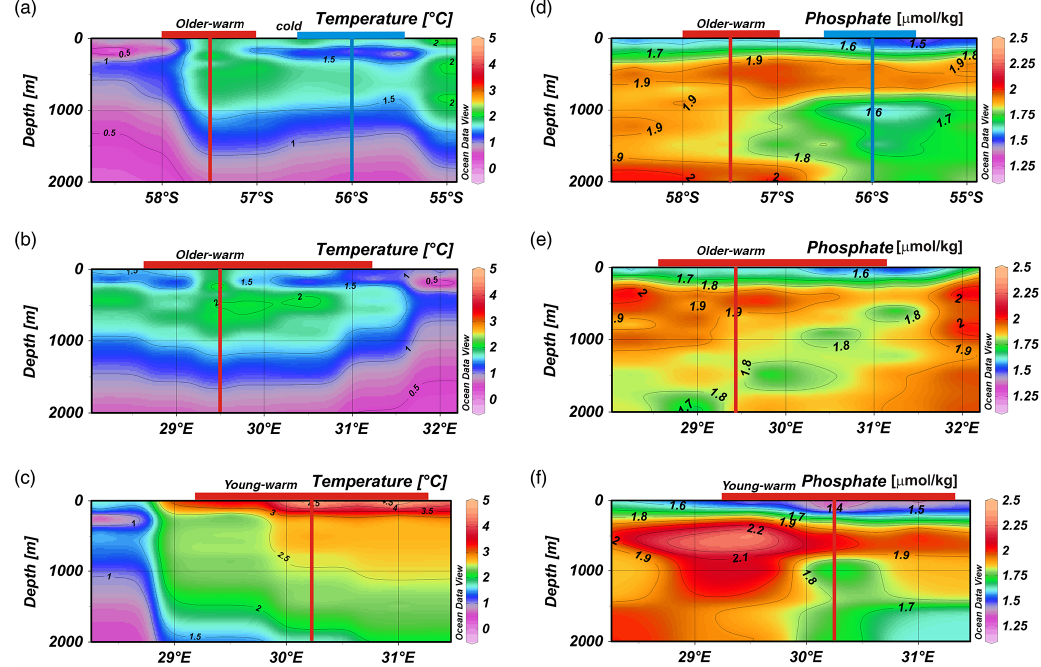
Figure 3. Temperature and dissolved phosphate profile data to a depth of 3000m, for Transect E1 ( a and d ), Transect E2 ( b and e ) and Transect E3 ( c and f ). Vertical red lines (at 57.5 ◦ S in (a) and (d) , 29.5 ◦ E in (b) and (e) and 30.25 ◦ E in c and f ) indicate the approximate position of the centre of the older and young warm-core eddies respectively and vertical blue lines (at 56 ◦ S in a and d ) similarly indicate the position of the cold-core eddy. The horizontal red and blue bars above these vertical red lines, in turn, indicate the estimated horizontal extent of the eddies, within the 10cm SSHA contour intervals.